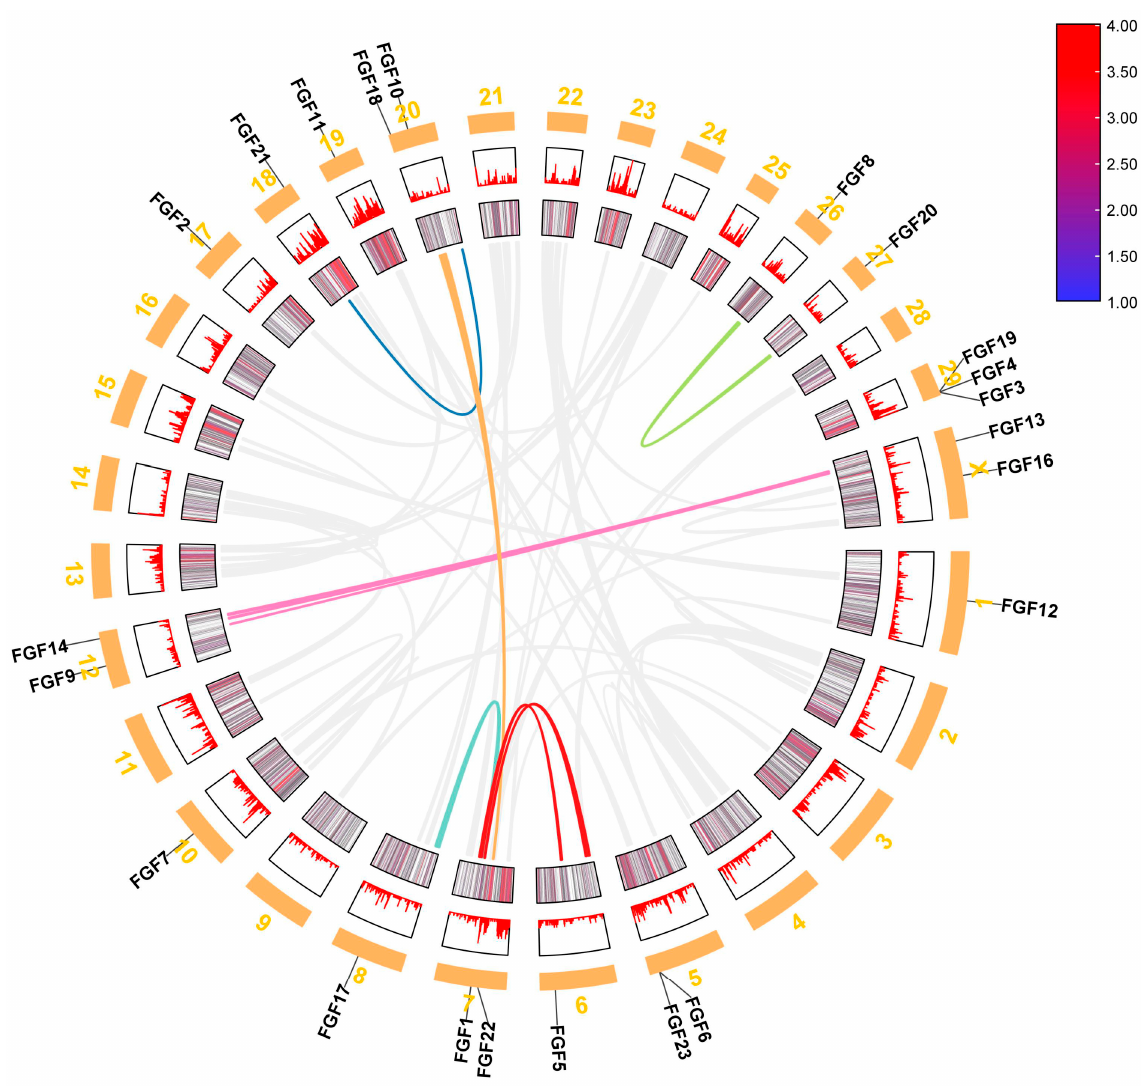
Figure 4. Repetitive gene analysis of FGF gene in Bos taurus genome.